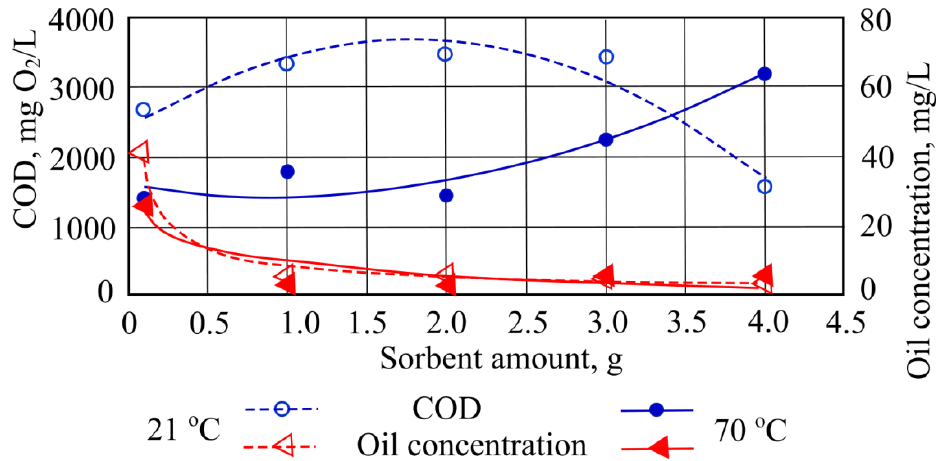
Figure 7. Chemical oxygen usage and oil concentration when different quantities of hydrophobic peat sorbent are added to the wastewater. peat sorbent are added to the wastewater.